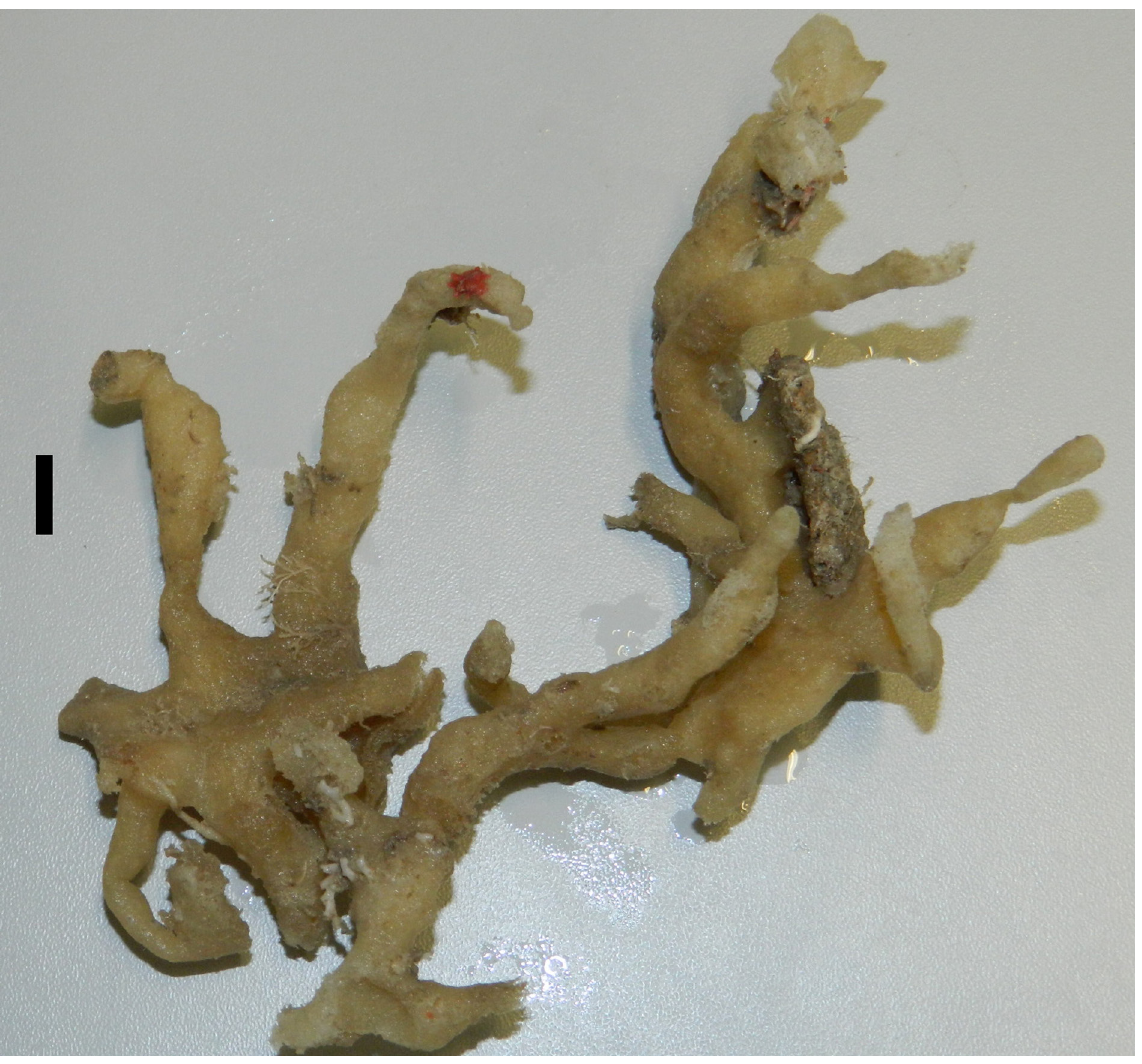
Fig. 7. Haliclona ( Flagellia ) hamata (Thiele, 1903) subgen. et comb. nov., habitus of ZMA Por. 09285 from Sumba, Indonesia (scale bar = 1